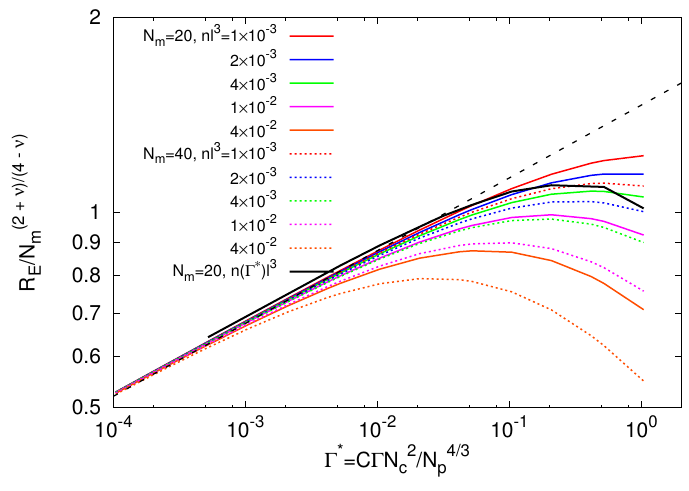
Figure 2. Theoretical prediction of the dependence of the polymer extension on the effective interaction strength Γ ∗ for various ion concentrations n and the polymer lengths N m = 20 and 40. The thick black line is the simulation result for N m = 20, N c = 147 and L / l = 200